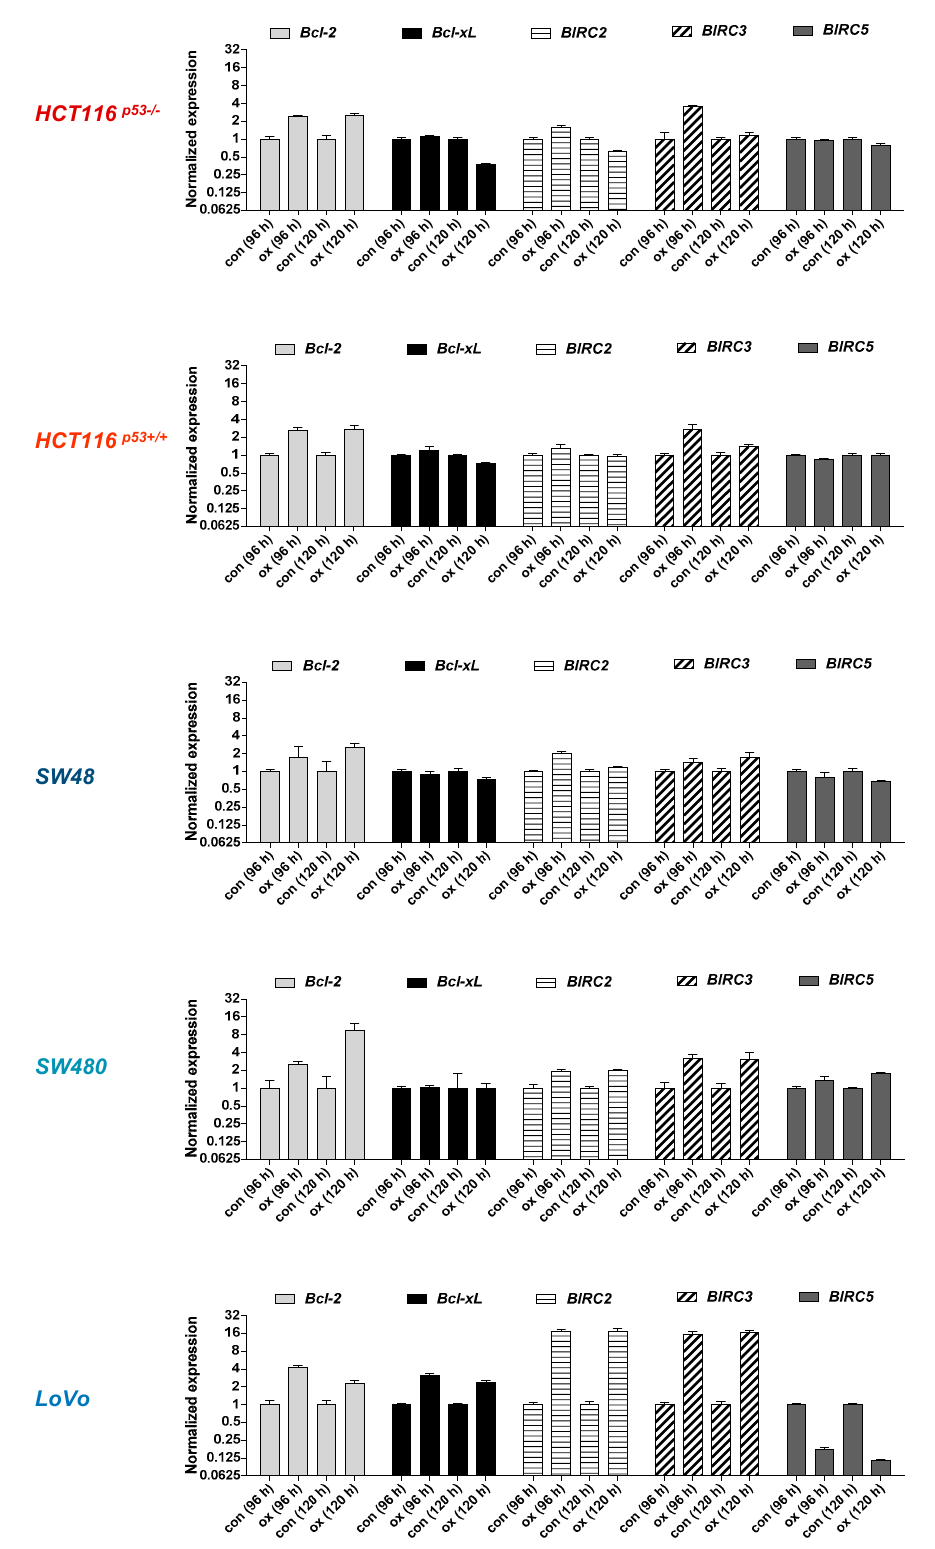
Figure A2. CRC cells were treated with 2.5 µ M oxaliplatin. 96 and 120 h later, expression of the anti-apoptotic factors Bcl-2 , Bcl-xL , BIRC2 (c-IAP1) , BIRC3 (c-IAP2) , and BIRC5 (Survivin) was measured by qPCR.